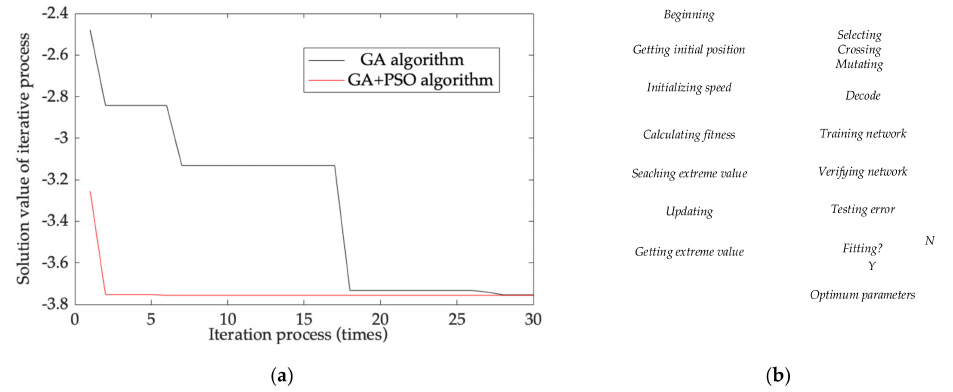
Figure 8. Performance improvement and its implementation. ( a ) Performance improvement compari- son of GA and PSO-GA; ( b ) implementation flow chart of the novel model.